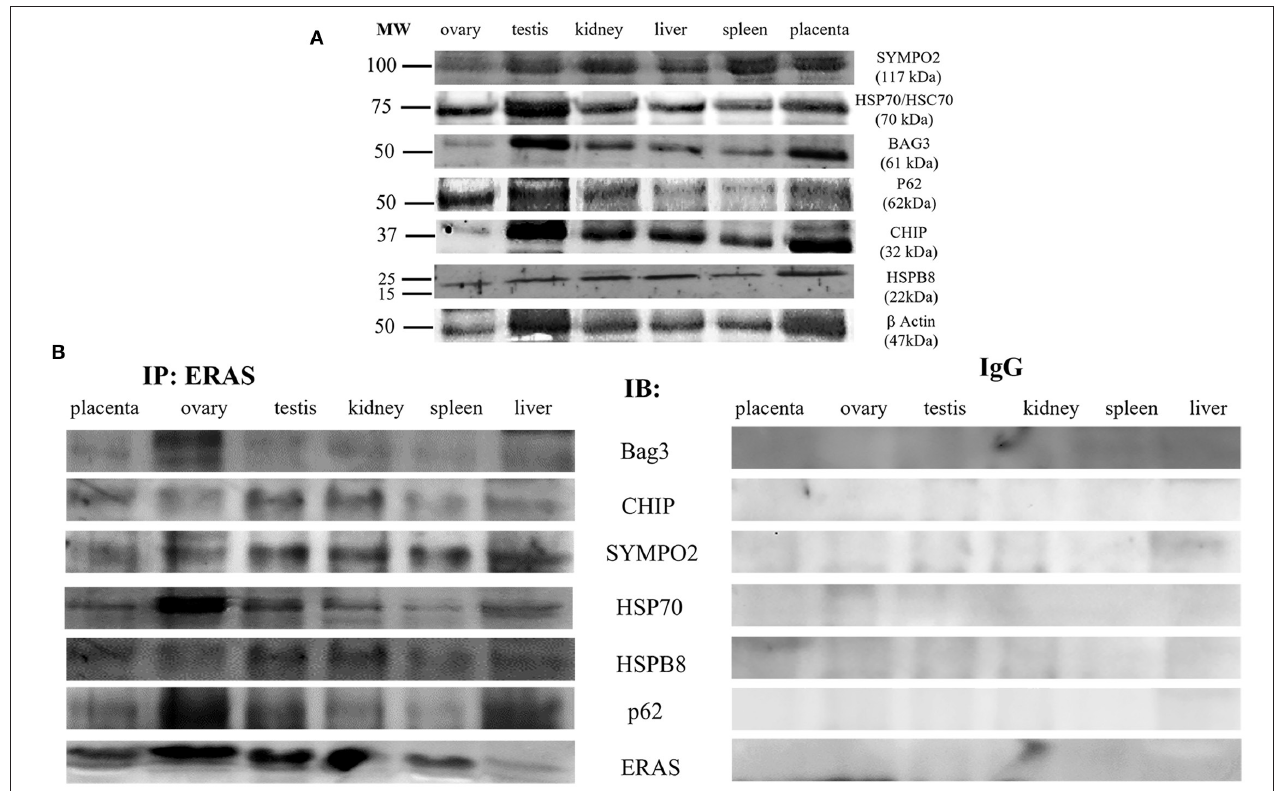
FIGURE 6 | (A) Representative WB analysis and (B) ERAS immunoprecipitation (IP) in equine tissues from several animals. WB analysis carried out on IP revealed that ERAS interacted with some of proteins involved in